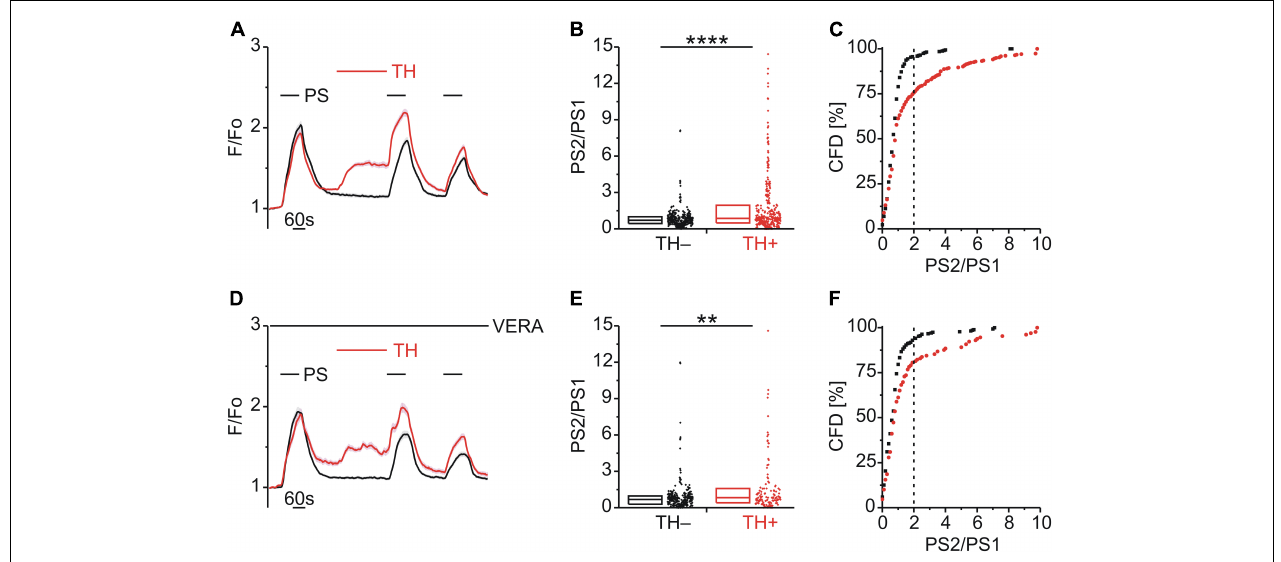
FIGURE 6 | Store released calcium sensitizes TRPM3. (A–C) Calcium signals from DRG neurons (A) during repeat application of pregnenolone sulfate (PS; 40 µ M) and with or without the SERCA inhibitor thapsigargin (TH; 2 µ M) applied between PS1 and PS2. Cells that were treated with TH are indicated in red (TH+; A–C , 336 neurons) and those untreated with TH are shown in black (TH–; A–C , 319 neurons). PS2/PS1 ratios are shown as a simple distribution ( B , boxes indicate quartiles and centerline median) and cumulative frequency distribution ( C ; CFD). Two TH+ ratio values (“16.4” and “19.1”) in (B) are not displayed for better visibility but were included in the analysis. Each dot-like symbol in (B,C) represents the ratio value calculated for a single, individual cell. Values derive from 12 measurements with cells from four mice. (D–F) Calcium signals from DRG neurons (D) during repeat application of PS and with or without TH applied between PS1 and PS2 and all the while in the presence of the CaV inhibitor verapamil (VERA; 20 µ M). Cells that were treated with TH are indicated in red (TH+; D–F , 129 neurons) and those untreated with TH are shown in black (TH–; D–F , 270 neurons). Two TH+ ratio values (“18.2” and “26.3”) in (E) are not displayed for better visibility but were included in the analysis. Values derive from eight measurements with cells from two mice. TH+ and TH– groups (B,E) were compared with Mann-Whitney U -tests. ** P < 0.01, **** P < 0.0001.